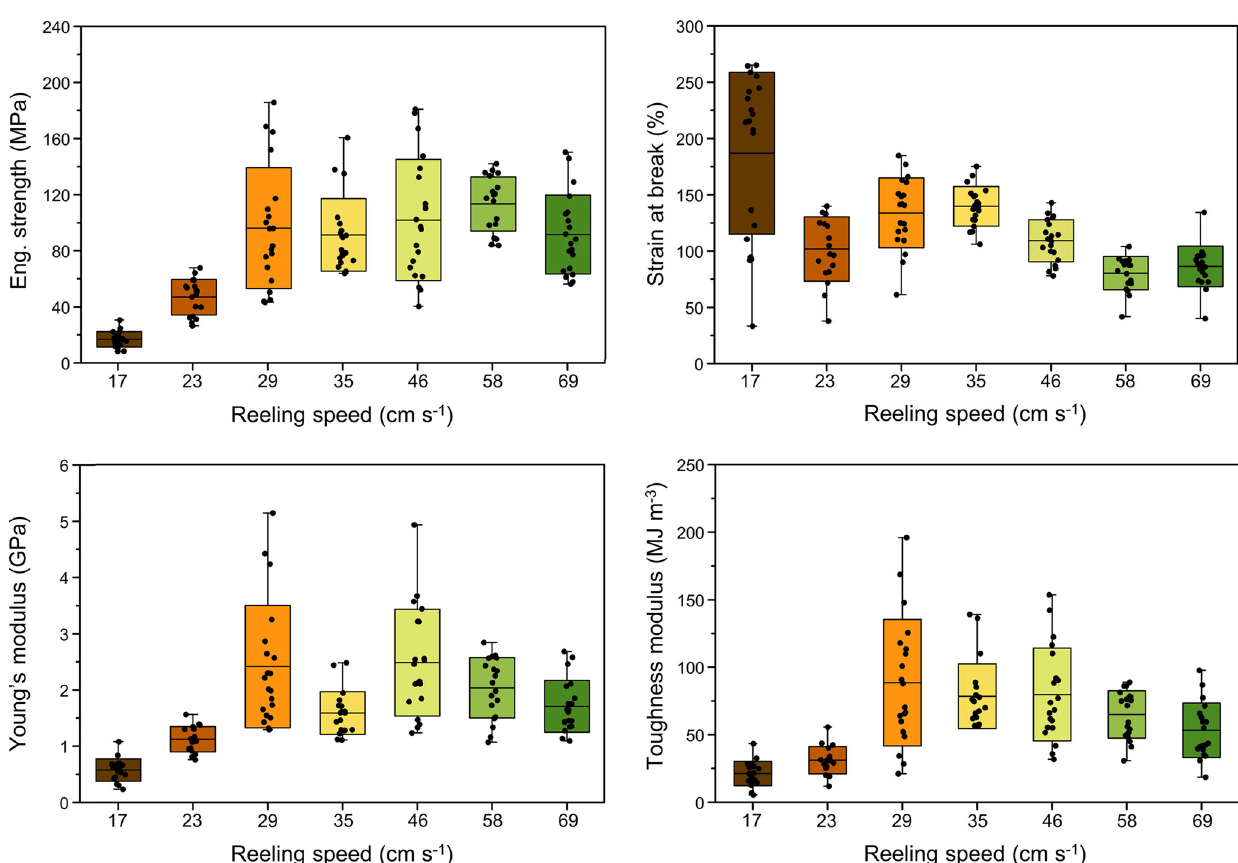
Fig. 5 Dependence of the mechanical properties of NT2RepCT fi bers on the reeling speed. A 750mM acetate (Na) buffer at pH 5 was used as spinning bath. This fi gure depicts the data as a box plot, where each data point represents one measurement, whiskers indicate the minimal and the maximal value, the boxes show ±one standard deviation, and the horizontal line in the middle of the boxes represents the mean value of n ≥ 10. The corresponding stress- strain curves are shown in Supplementary Fig. 13. Other spinning parameters associated with this experiment are found in Supplementary Table